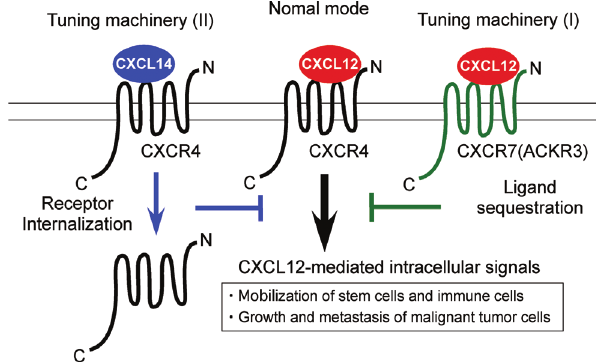
Figure 1 Proposed mechanism of CXCL14-mediated inhibition of the CXCL12-CXCR4 signaling